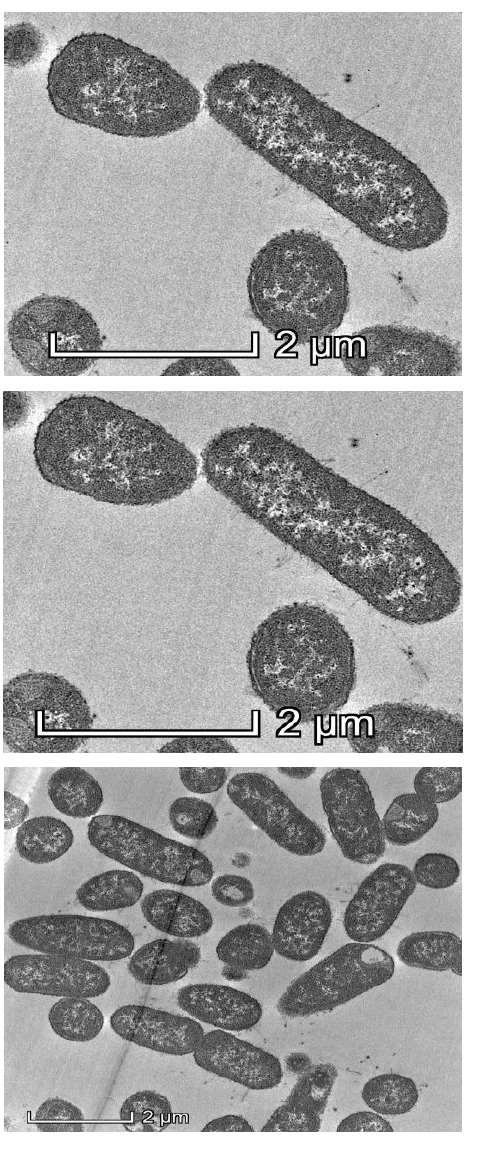
Figure 2. Representative TEM images of 50 nm sections of untreated control ( left panel ) and k9w6-treated K. pneumoniae (KP2) ( right panel ), (black arrow) show k9w6 attached to the bacteria wall. TEM images show weakened and disrupted cell wall after exposure to k9w6 at MOI 1 for 1 h.